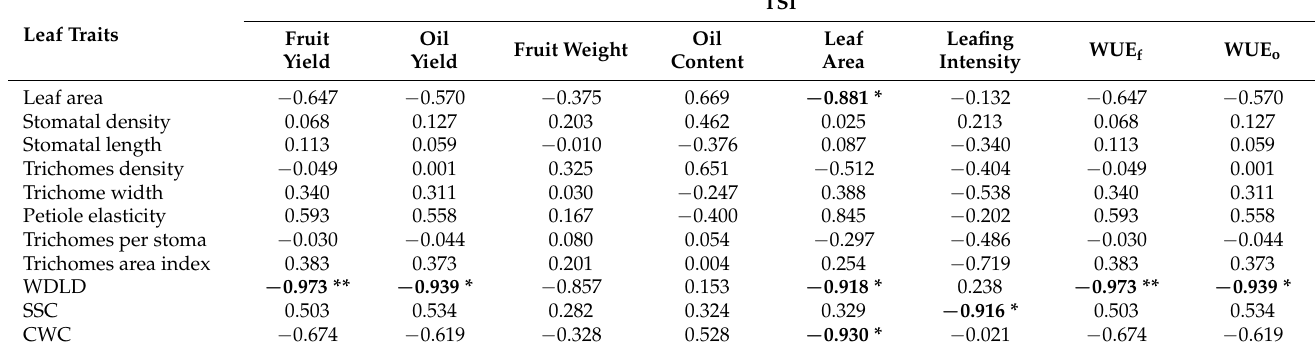
Table 5. Correlation coefficients between leaf traits and stability indices (TSIs) of fruit yield, oil yield, fruit weight, oil content, leaf area, leafing intensity, and water use efficiency for fruit (WUE f ) and oil production (WUE o ) of Picholine Marocaine, Arbequina, Sevillenca, Madural, and Frantoio in response to water